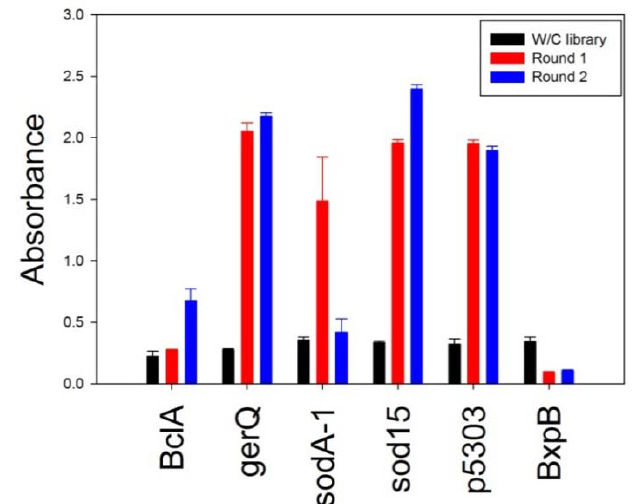
Figure 2. Polyclonal phage ELISA using phage prepared from the initial library and